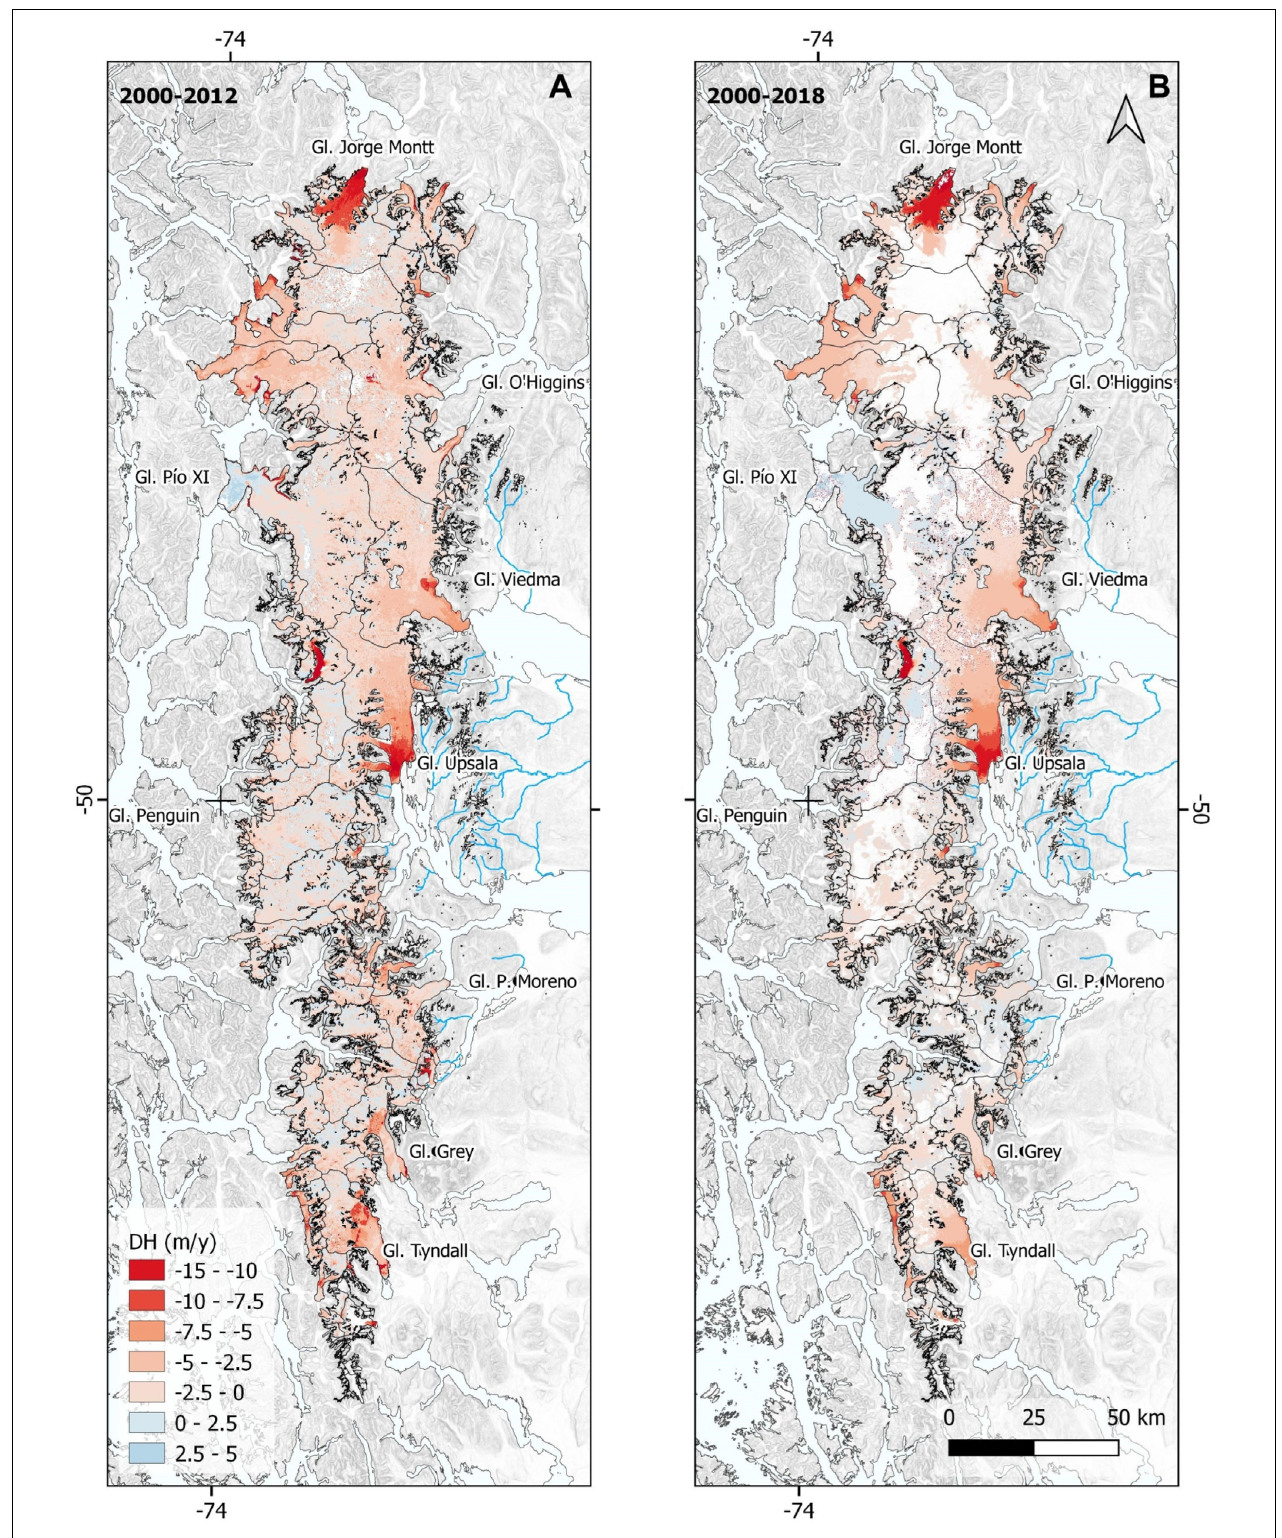
FIGURE 10 | (A) Mean annual ice thickness changes for the SPI between 2000 and 2012, derived from the SRTM and ASTER DEMs (Willis et al., 2012a). Note that the ice loss is larger in the tongues of the large outlet glaciers and, in many cases it extends toward the higher sectors near the ice divides. (B) Same as A, but for the period 2000–2018 (Dussaillant et al., 2019). The anomalous behavior of Pío XI glacier is also evident in these maps.